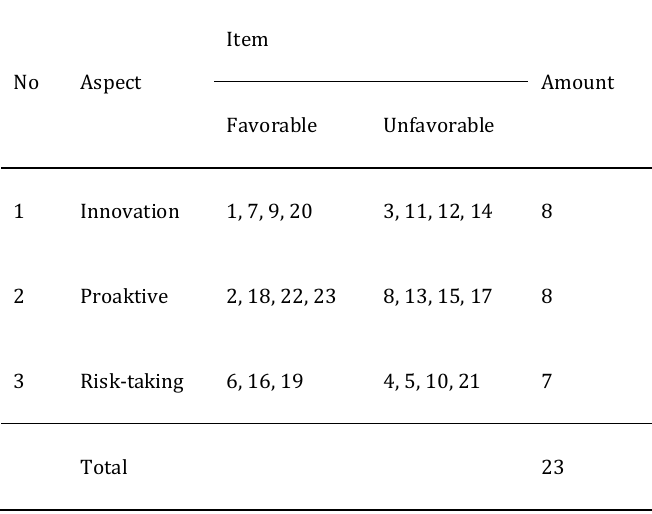
Table 5 The numbering of the intrapreneurship scale after trying out